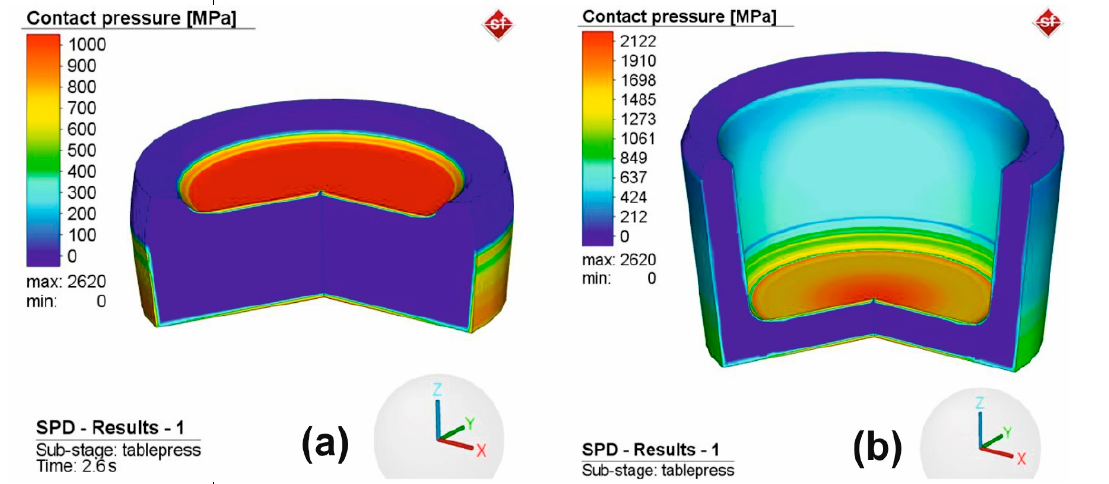
Figure 6. Pressure fi eld: ( a ) at 2.6 s from the SPD beginning and ( b ) at 8 s from the SPD beginning.